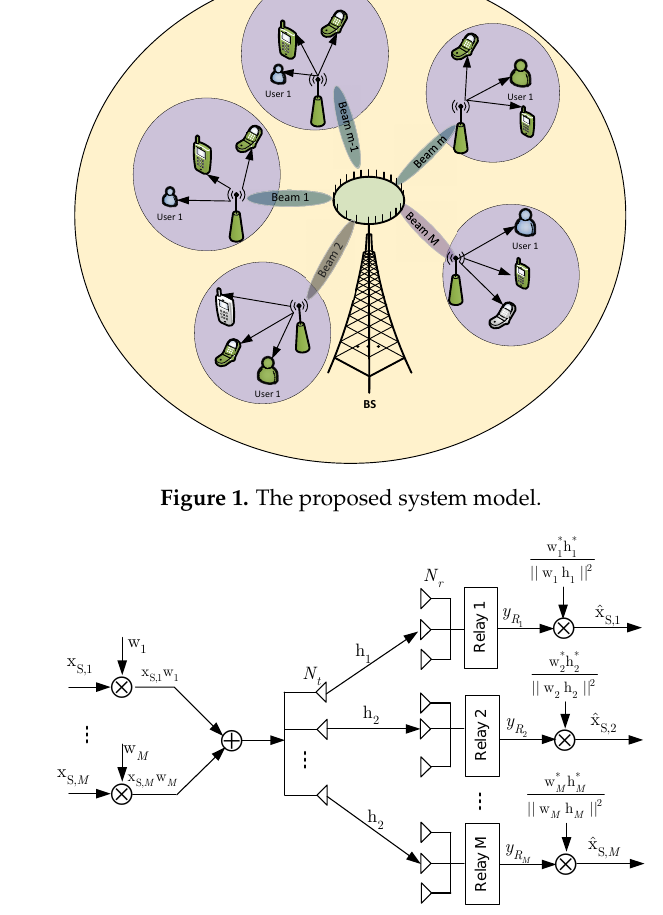
Figure 2. The block diagram of the first hop of the proposed multi-relay beamforming